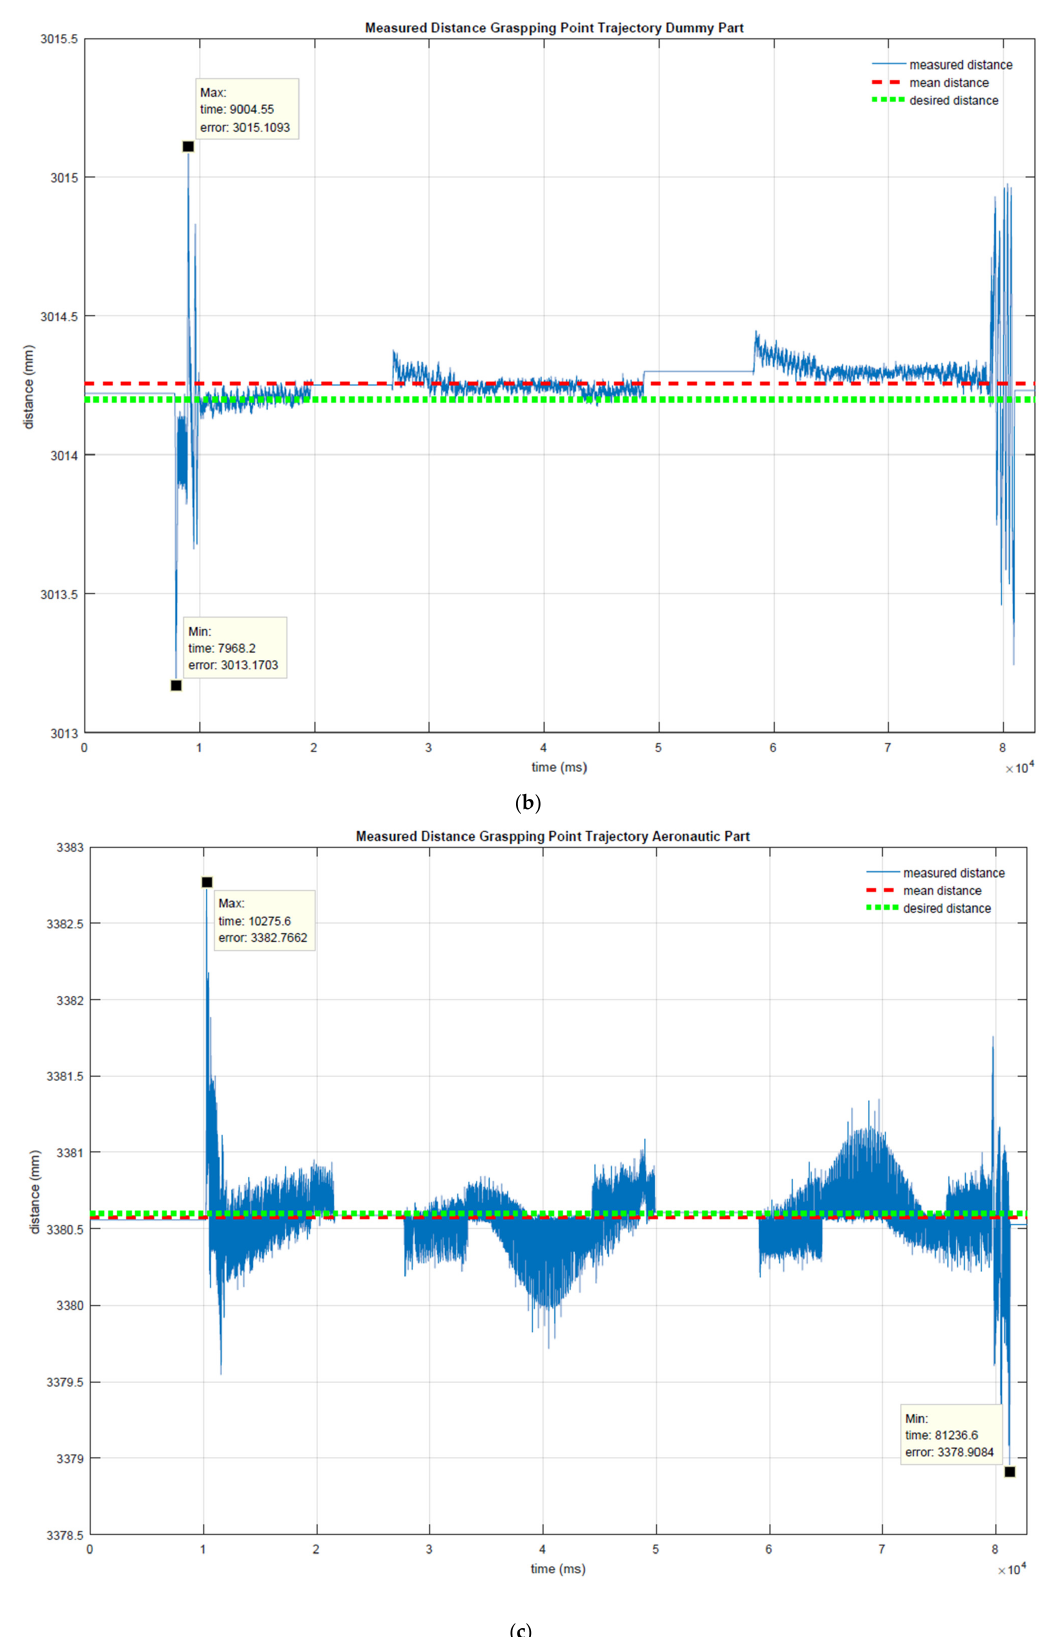
Figure 14. Measured distance between the grasping points during the trajectory ( a ) without trajectory ( b ) with dummy part and ( c ) with aeronautic part. The maximum errors occurred during the initial and final movements, due to accel- eration and deceleration moments.